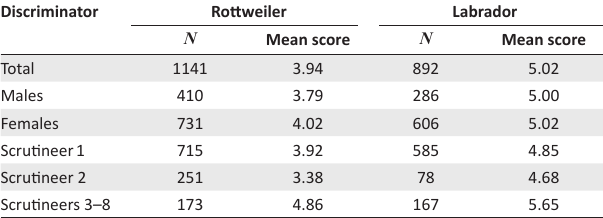
TABLE 1b: Mean hip dysplasia grading score in Rottweilers and Labrador retrievers and in males versus females and primary versus secondary versus remaining scrutineers for both hips using numerical data (0–9 per